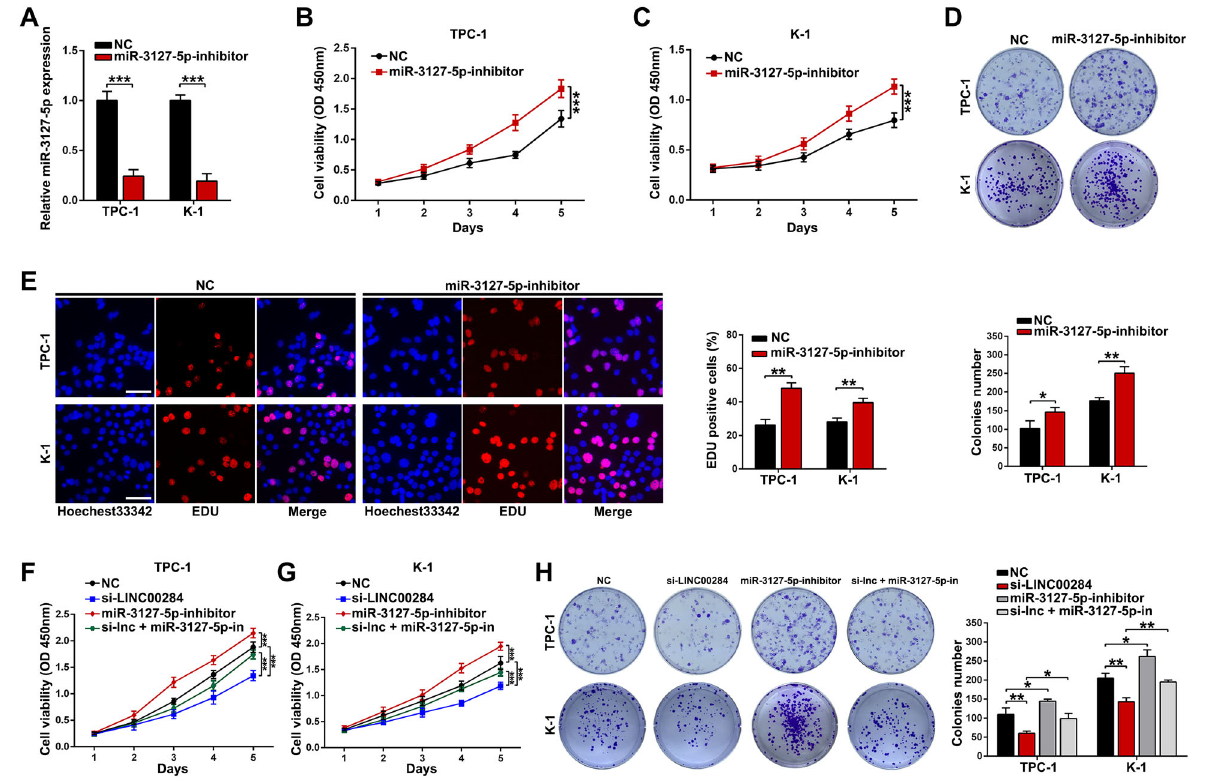
Fig. 5 Knockdown of LINC00284 inhibits tumor proliferation via suppressing miR-3127-5p. A After being treated with miR-3127-5p inhibitor or control miRNA, the transfection ef fi ciency was detected with qRT-PCR in TPC-1 or K-1 cells. B-E, CCK8, colony formation, and EdU experiments were adopted to measure the proliferation viability of TPC-1 and K-1 transfected miR-3127-5p inhibitor (scale bar: 100 μ m for EdU assay). F – G The growth ability of TPC-1 and K-1 cells after cotransfection with si-LINC00284, miR-199a-5p inhibitor, or control miRNA were determined by CCK8 and colony formation assays. Values indicated mean ± standard deviation. * P < 0.05, ** P < 0.01, and *** P <